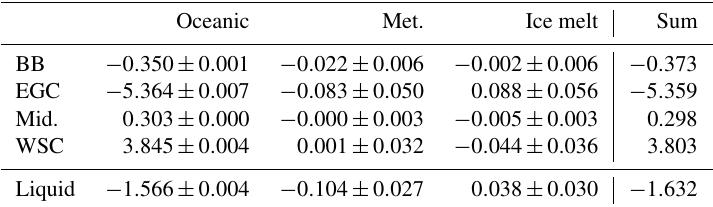
Table 5. Mean volume fluxes (Sv ± standard deviation) for the components of the Fram Strait flux (Belgica Bank, BB; East Greenland Current, EGC; mid-strait, Mid.; West Spitsbergen Current, WSC) from the three-end-member (3EM) model. Positive values indicate fluxes into the Arctic. Oceanic Met. Ice melt